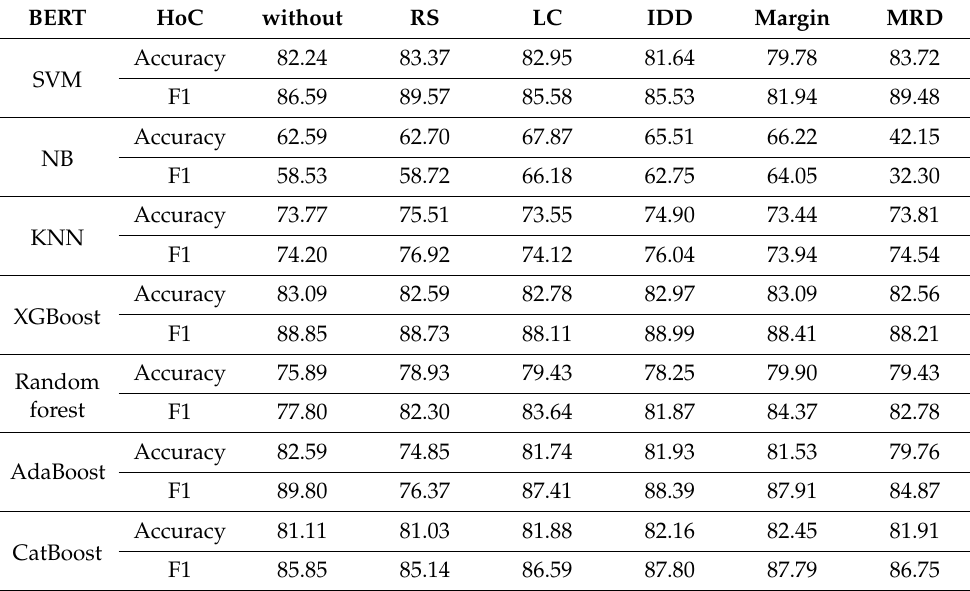
Table 8. Comparison of results with and without AL methods (BERT) for DDI dataset.